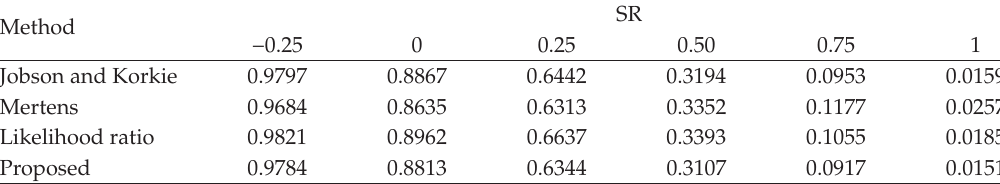
Table 3: Fund: p values for SR.